Question: Write a single sentence explaining what this figure depicts.
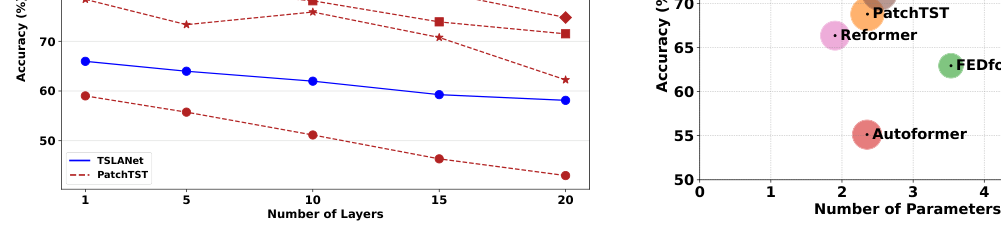
Answer: A comparison between TSLANet vs. PatchTST in terms of accuracy with varying the number of layers in both for different data percentages from the uWaveGesture- LibraryAll dataset.